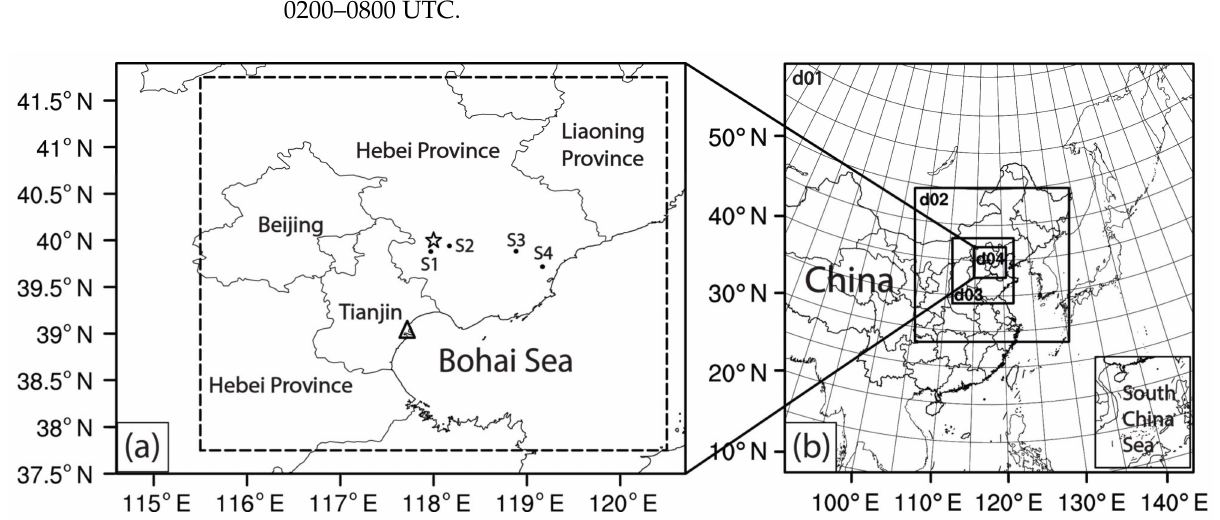
Figure 1. ( a ) Study area where the severe convective storm occurred. The black dots indicate the locations of the ground-based automatic stations (S1, S2, S3, and S4) that will be mentioned in Figure 4. The dashed rectangle area denotes the area analyzed in Figures 3, 7 and 8. The black triangle symbol represents the location (39.044 ◦ N, 117.717 ◦ E) of Tianjin weather radar that will be shown in the following part of the paper. The black asterisk symbol represents the grid point location (40 ◦ N, 118 ◦ E) of National Centers for Environmental Prediction (NCEP) Final (FNL) reanalysis data soundings that will be shown in Figure 6. ( b ) Geographic locations of the WRF model domains. The innermost domain (d04, i.e., the domain No.4) covers the whole area shown in ( a